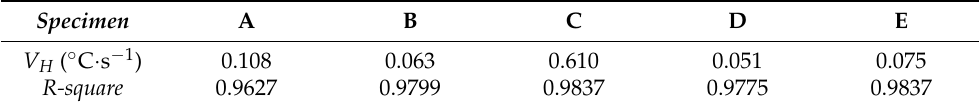
Table 6. Summary of heating rate measurements and correspondent R-square values.